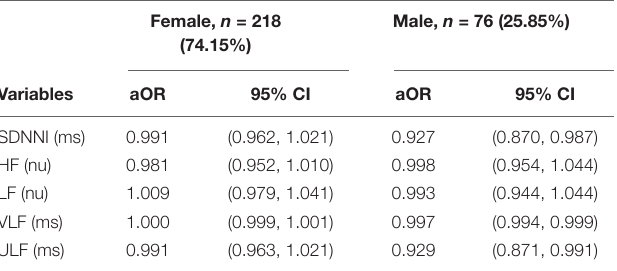
TABLE 6 | Adjusted regression coefficients (95% confidence interval) between HRV parameters and POD, stratified by sex.